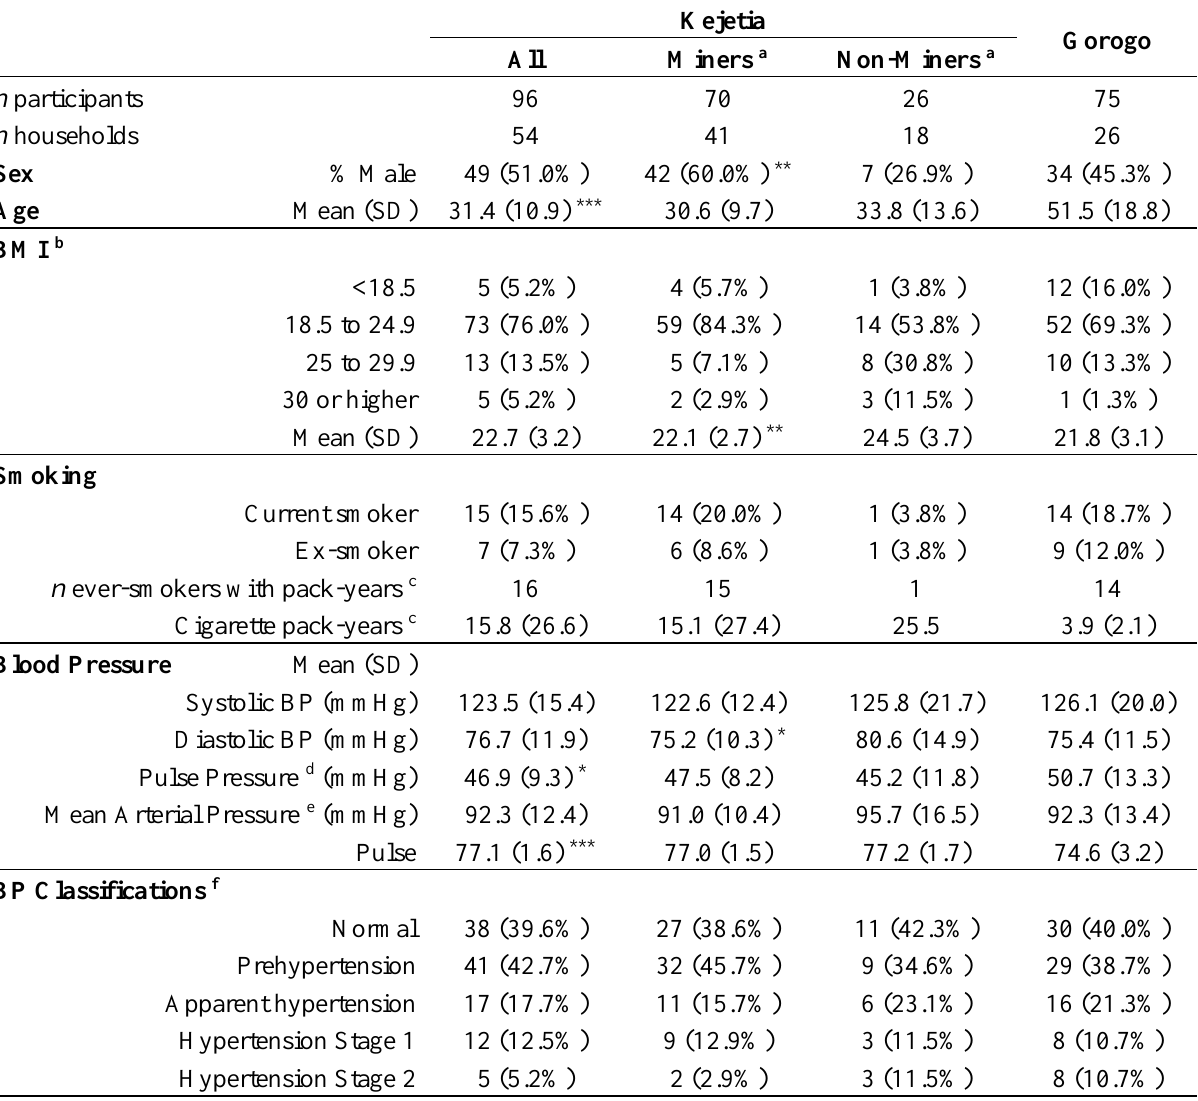
Table 2. Demographics and BP of participants in Kejetia and Gorogo, and stratified by mining